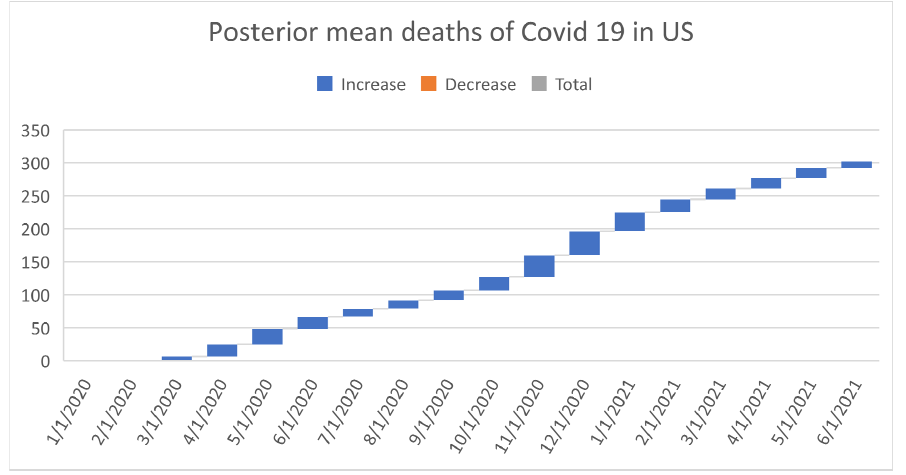
Figure 11. Progressive posteriors mean deaths in US. For readability, note that 4/1/2020 refers 1 April 2020.